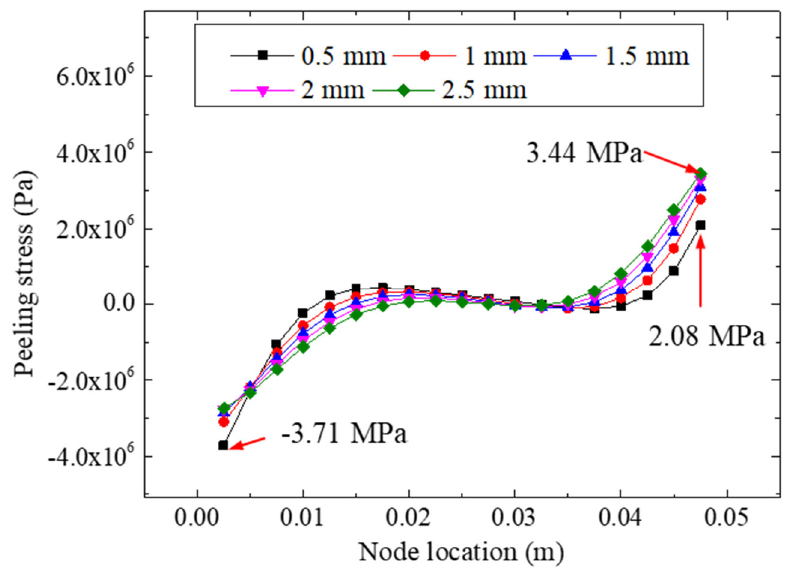
Figure 15. Peeling stresses for different bonding thicknesses.